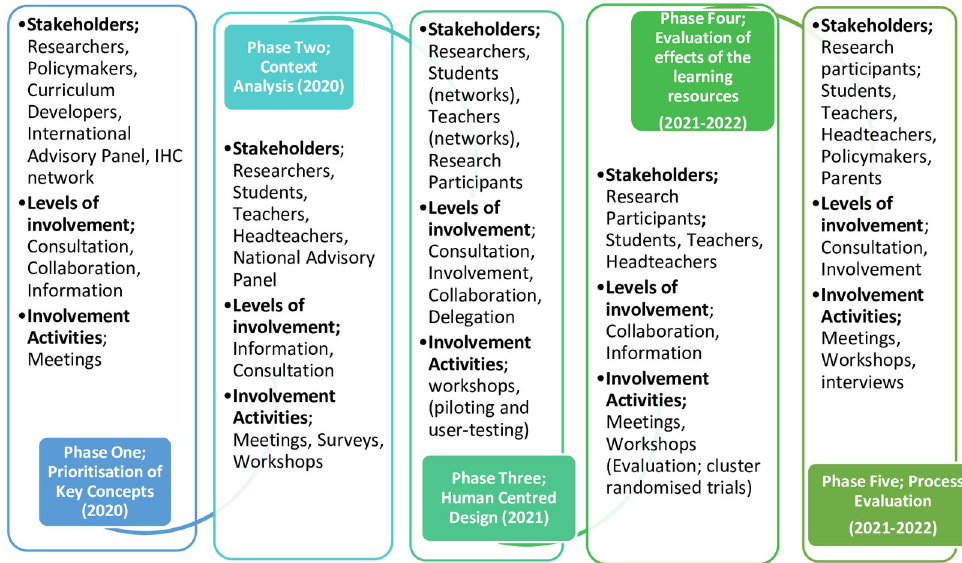
Fig 2. Overview of the stakeholder engagement